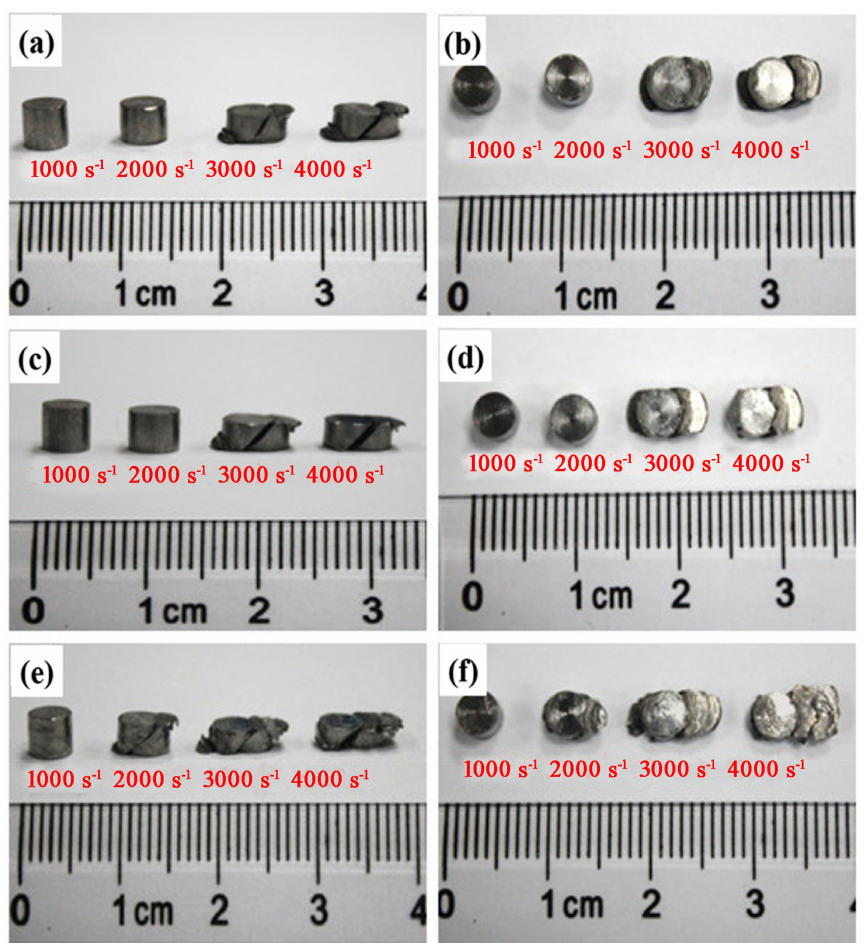
Figure 3. Ti-6321 samples with different microstructures at different strain rates: ( a , b ) EM; ( c , d ) DM; ( e , f )